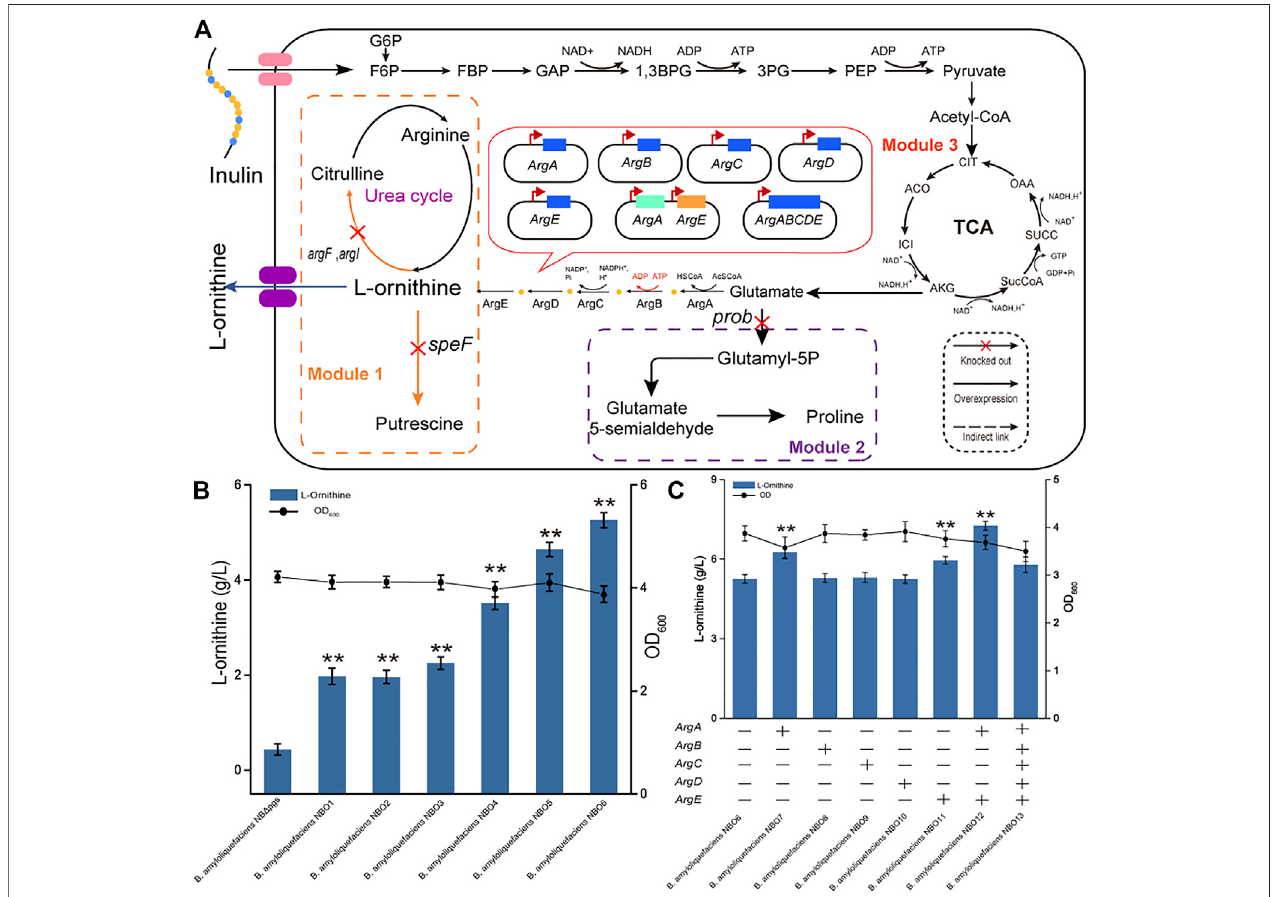
FIGURE2| EffectoftheL-ornithinesynthesismoduleonputrescineproduction. (A) SchematicoverviewofL-ornithinecatabolismpathway,precursorcompetition pathway, and synthesis pathways. The main pathway of L -ornithine catabolism is catalyzed by L-ornithine carbamoyltransferase and L -ornithine decarboxylase. Glutamate is a key starting material for L-ornithine synthesis. Blocking proline synthesis improves the supply of the precursor glutamate for L-ornithine synthesis. Some key genes in the L-ornithine synthesis pathway included amino-acid N-acetyltransferase (ArgA), acetylglutamate kinase (ArgB), N-acetyl-gamma-glutamyl- phosphatereductase(ArgC),acetylornithineaminotransferase(ArgD),andacetylornithinedeacetylase(ArgE).G6P:Glucose-6-Phosphate;F6P:Frucose-6-Phosphate; GAP: Glyceraldedyde-3-phosphate; 1,3BPG: 1,3-Bisphospho-glyerate; 3 PG: 3-phosphoglycerate; PEP: Phosphoenolpyruvate (B) The L-ornithine titers of the recombinant strains lacking argF , argI , speF , and prob . All data were the average of three independent studies with standard deviations. The ** and * indicate p < 0.01 and 0.05 relative to the control strain B. amyloliquefaciens NB ( Δ pgsBCA ), respectively. (C) Overexpression of the L -ornithine synthase gene in B. amyloliquefaciens NBO6. “ + ” indicates thatthe relevant gene isoverexpressed in thestrain; “ - ” indicates thatthe relevant gene isnot overexpressed inthe strain. All data were the average of three independent studies with standard deviations. The ** and * indicate p < 0.01 and 0.05 relative to thecontrol strain B. amyloliquefaciens NBO6, respectively. Co- expression of genes with noticeable effect to further improve the fermentation